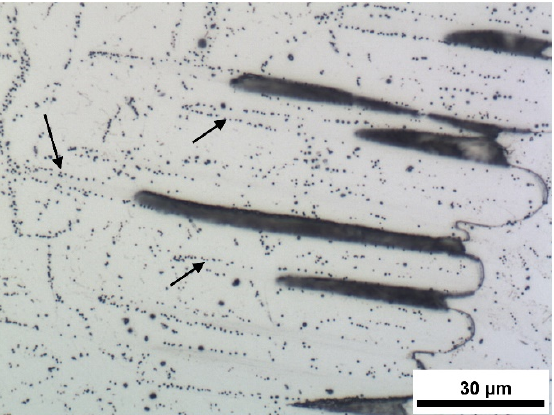
Figure 6. Undulating high-angle δ-ferrite grain boundary in the vicinity of WA decomposition products. The arrows indicate the sulfide networks along the original interface between WA laths and the ferritic matrix. LM.